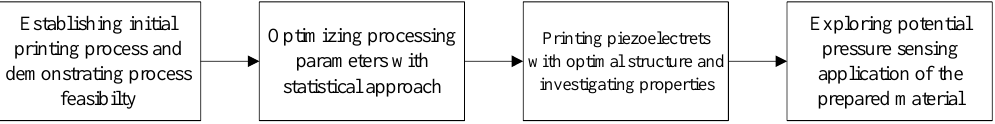
Figure 1. Overview of micropillar-based piezoelectret design fabrication and application.